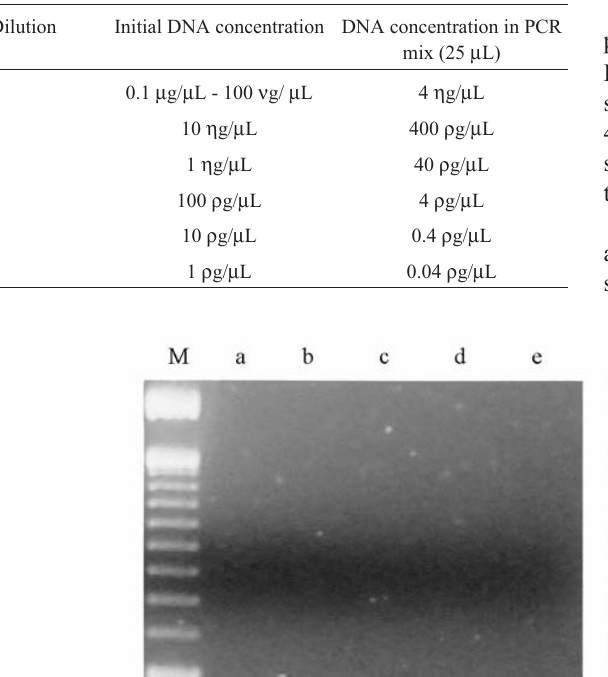
Table 1 - DNA dilutions and concentrations used to determine the sensitivity of the